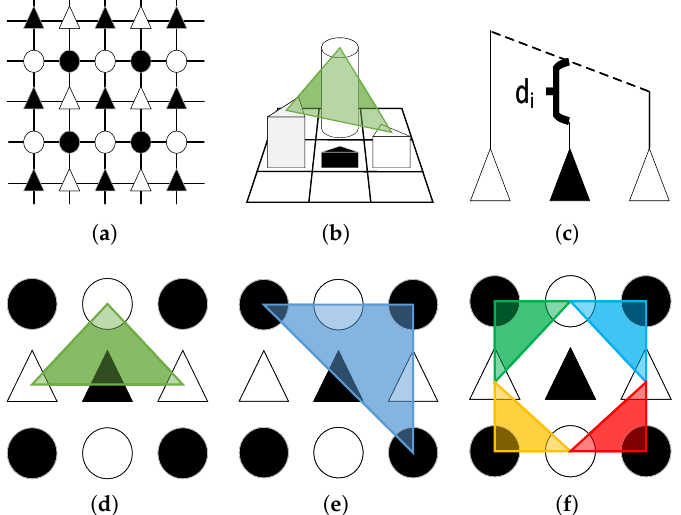
Figure 3. Structure of the Gaussian curvature optimization. ( a ) Illustration of the minimum vertex coloring domain decomposition; ( b ) A tangent plane; ( c ) Illustration of the projectionb distance;